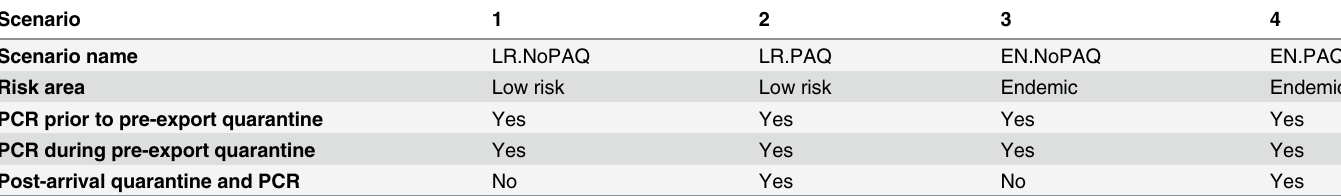
Table 1. Summary of four main scenarios for an AHS quantitative risk